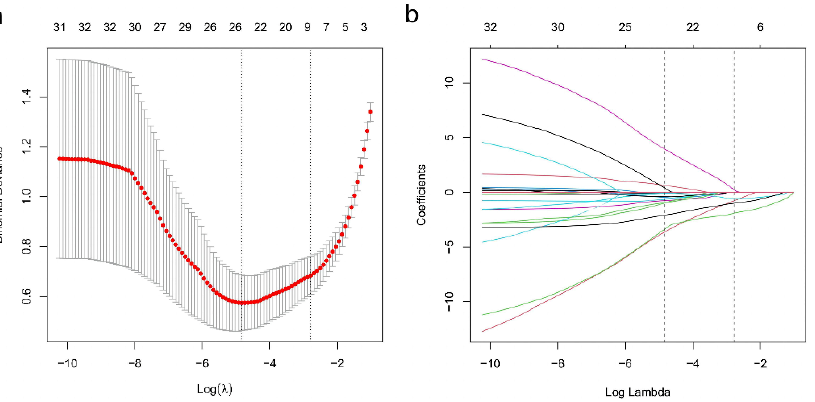
Figure 5. SWE, AP, and Conventional Ultrasound Imaging biomarkers’ selection using the least absolute shrinkage and selection operator (Lasso) algorithm. ( a ) The coefficient convergence graph for the feature selection process; ( b ) The ordinate is the binomial deviation, and the abscissa is log(λ). Afterward, the nomogram was developed based on the above six risk factors of breast cancer (Figure 6). According to this study, the nomogram’s sensitivity, specificity, positive predictive value (PPV), and negative predictive value (NPV) are 95.6%, 90.3%, 86.0%, 97.0%,